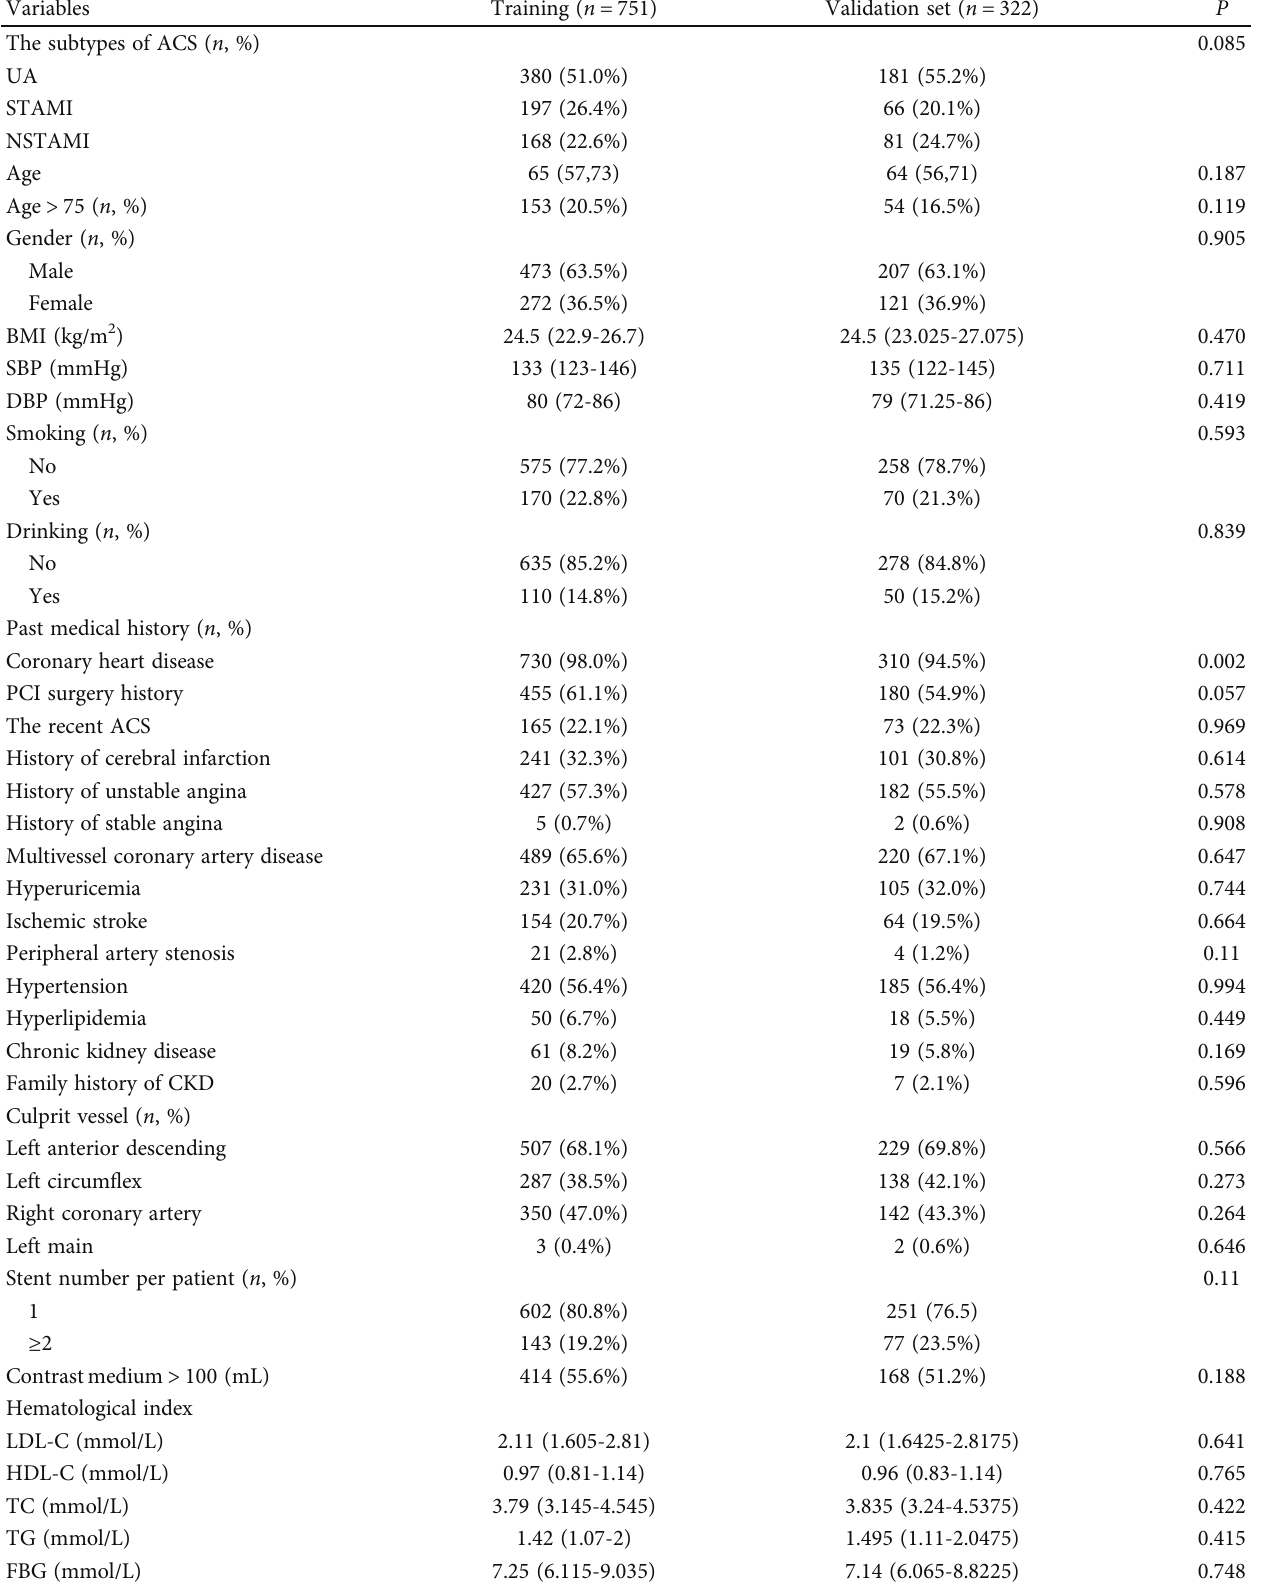
Table 3: Baseline characteristics of training and validation